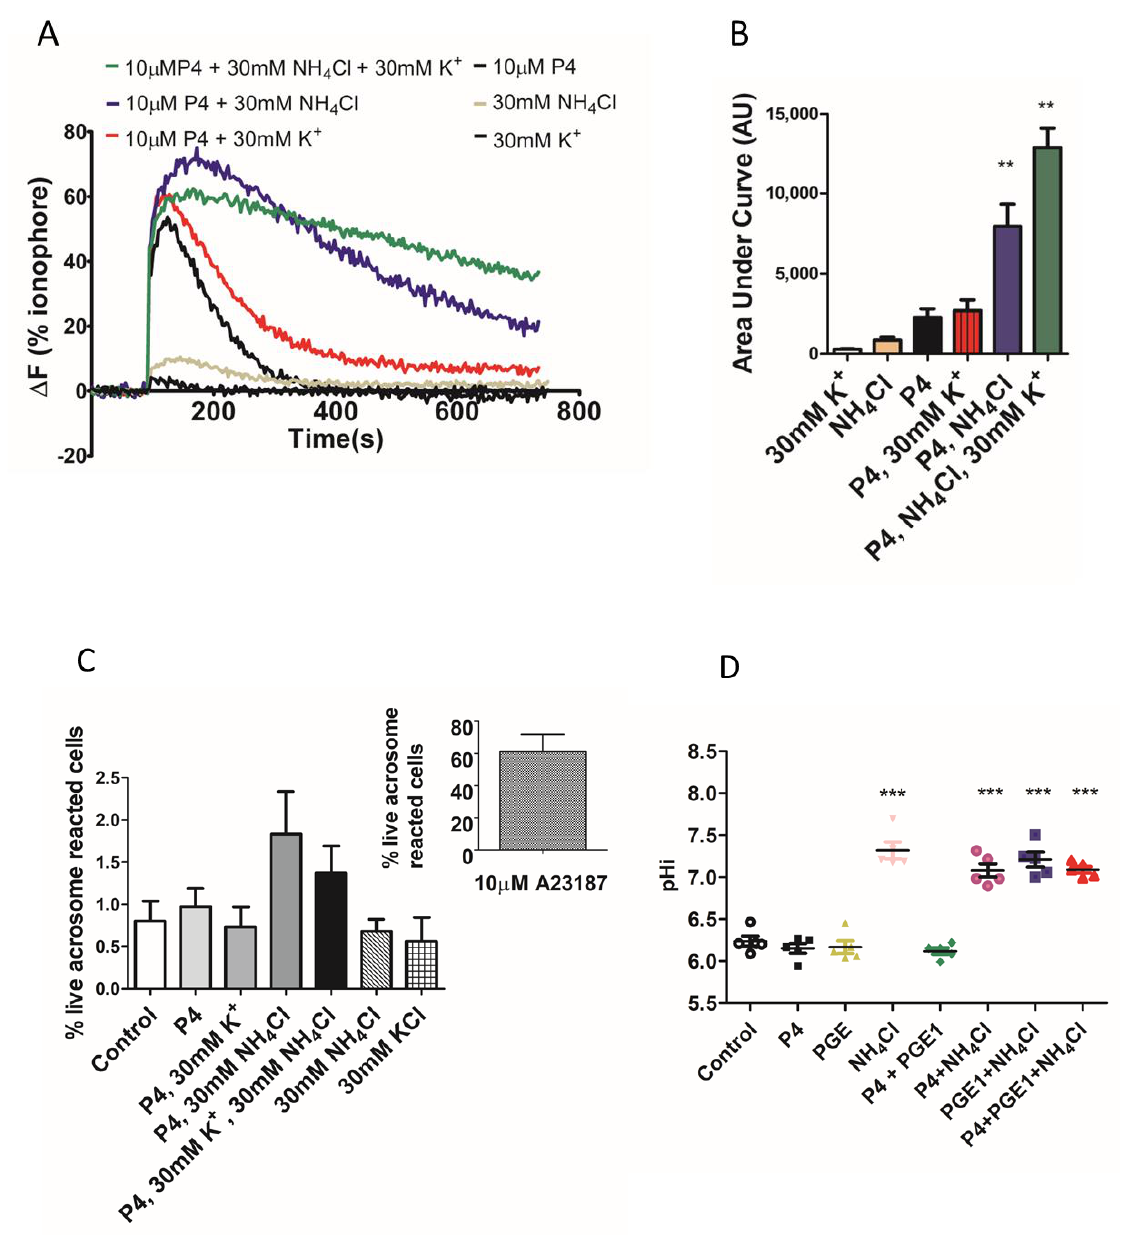
Figure 2. Co-application of NH 4 Cl and KCl significantly increases [Ca 2+ ]i but not acrosome reaction.